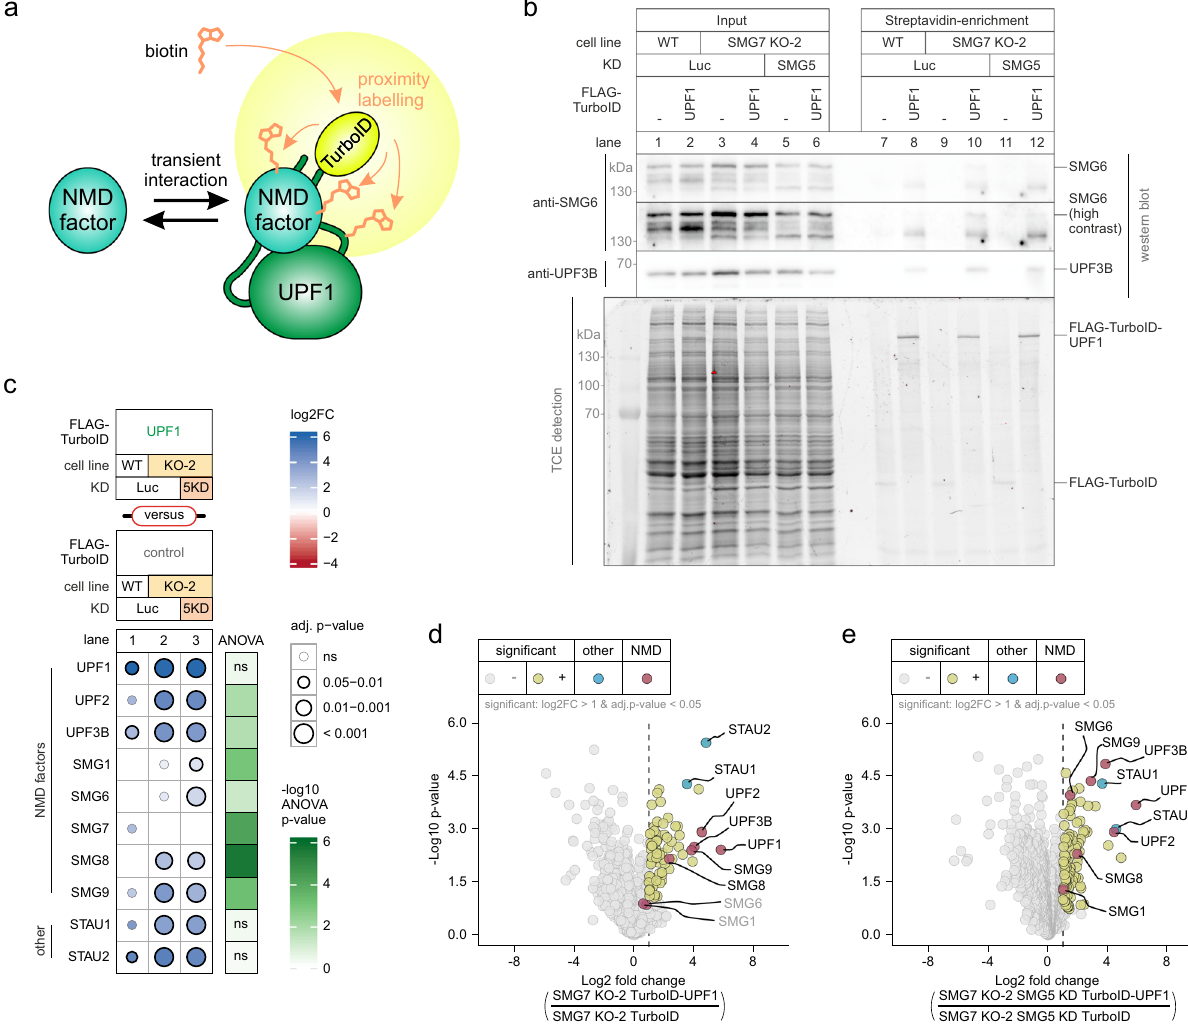
Fig. 6 UPF1 accumulates with NMD factors in SMG5-SMG7 depleted cells. a Overview of the TurboID-mediated proximity labeling of UPF1 binding partners. Transient UPF1 interactors are marked with biotin via TurboID catalysis. Biotinylated proteins are subsequently enriched with streptavidin beads. b Western blot and TCE (2,2,2-trichloroethanol)-mediated detection of input or streptavidin-enriched protein samples after proximity labeling in the indicated conditions ( n = 3 biologically independent samples). c Heatmap of mass spectrometry-based analysis of streptavidin-enriched biotinylated NMD and selected other proteins in the respective comparison of conditions ( n = 3 biologically independent samples). Colored points indicate the log2 fold change (log2FC) and point size corresponds to the adjusted p -value (adj. p -value; from two-sided Welch ‘ s t -test). Multiple testing between FLAG- TurboID-UPF1 in WT, SMG7 KO, and SMG7 KO + SMG5 KD was performed by ANOVA. d , e Volcano plots of mass spectrometry-based analysis of streptavidin-enriched biotinylated proteins in the respective comparison of conditions ( n = 3 biologically independent samples). d FLAG-TurboID-UPF1 against FLAG-TurboID control in SMG7 KO cells, ( e ) FLAG-TurboID-UPF1 against FLAG-TurboID control in SMG7 KO + SMG5 KD cells. The yellow color labeling indicates targets that are signi fi cant in the respective comparisons after two-sided Welch ’ s t -testing (log2 fold change (log2FC) >1 or |log2FC| >1; and adj. p -value <0.05). Points labeled in blue indicate other proteins of interest; points labeled in red indicate NMD factors. Highlighted proteins that were not signi fi cant in the respective comparisons are labeled with gray